Question: From the figure, is the trend upward or downward?
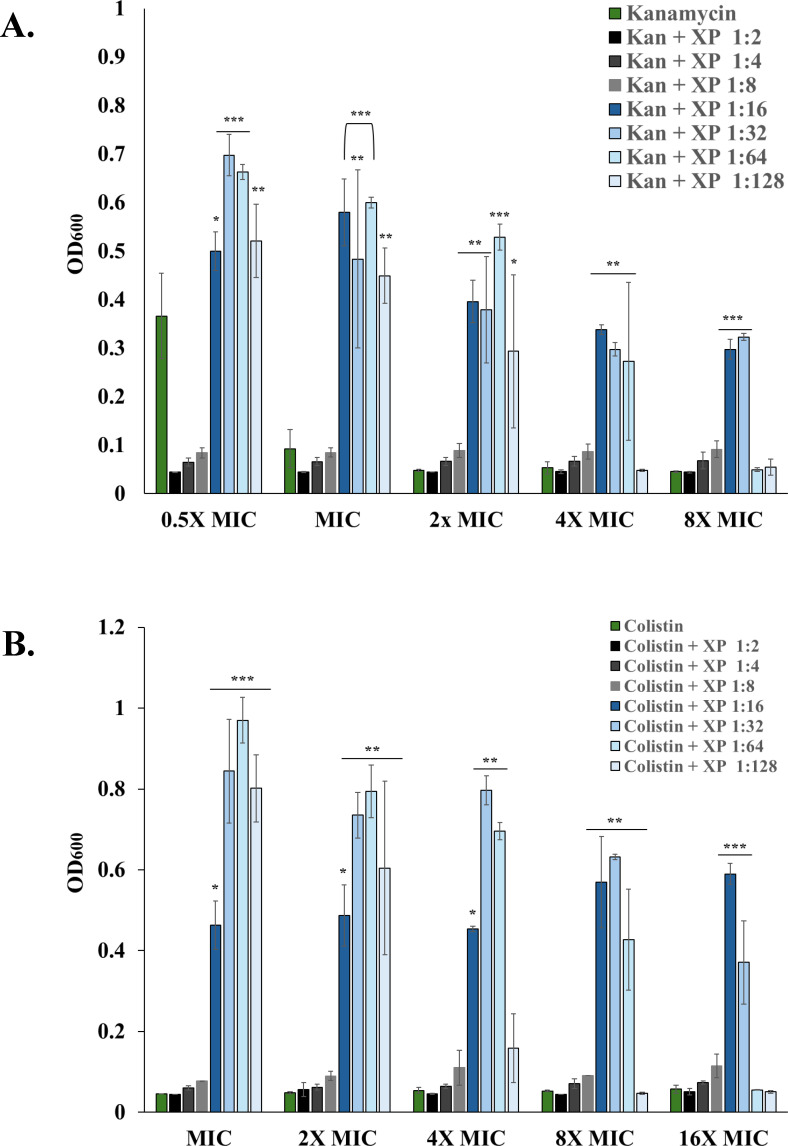
Answer: increasing